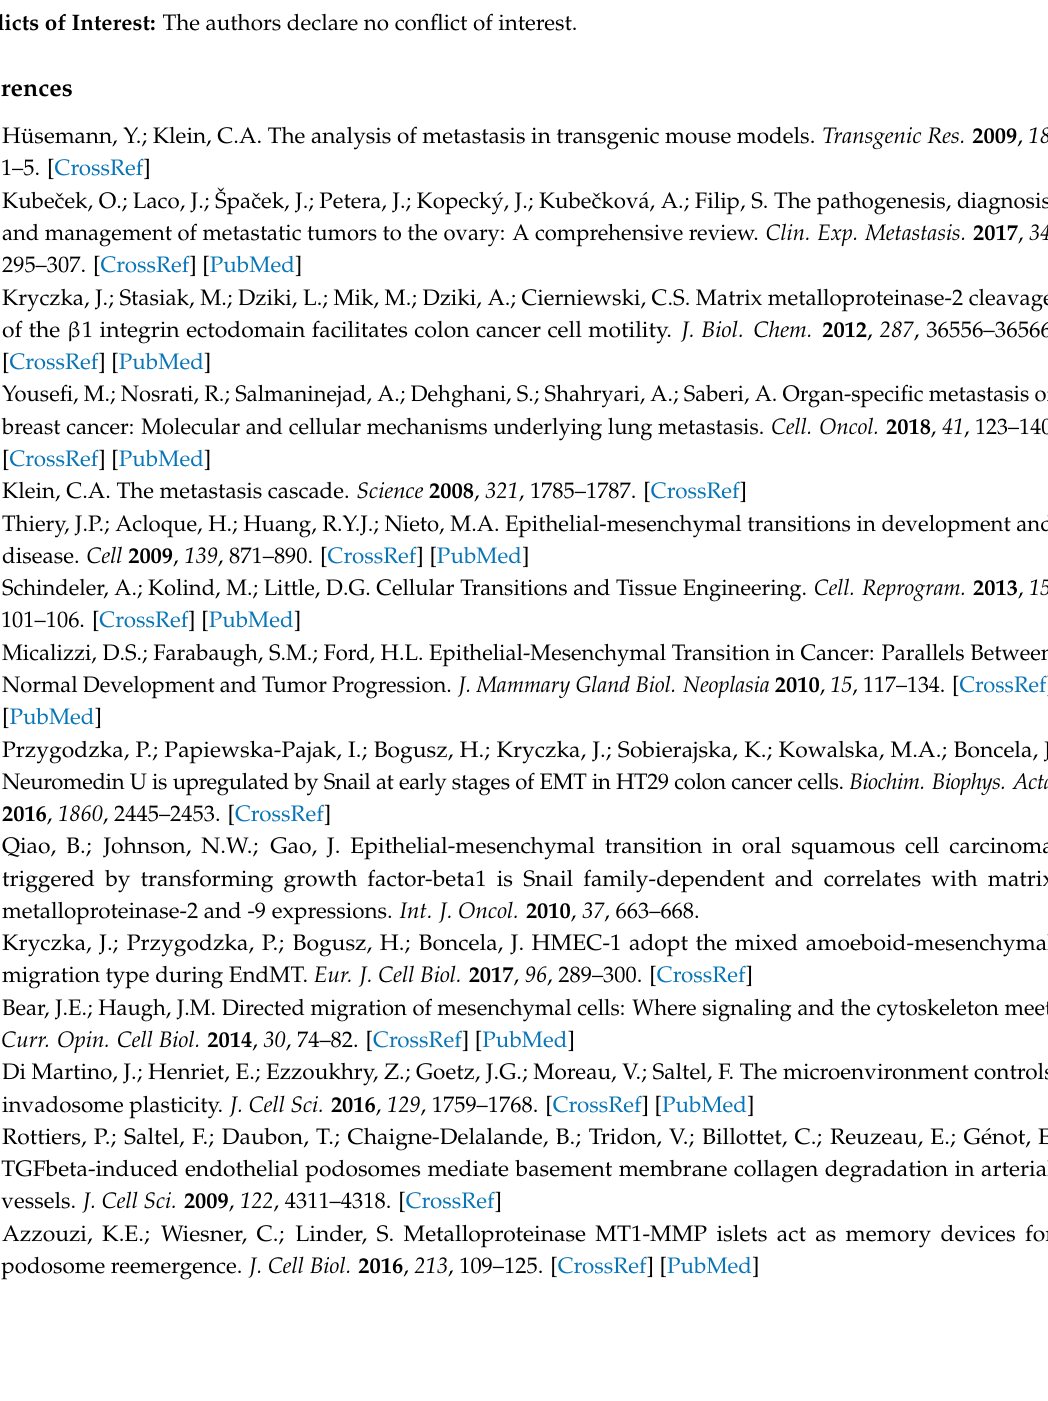
Figure S1: Invadosomes structures in HT-29 control cells, Figure S2: The representative image of Proteome Profiler Human Protease Array Kit (R & D System, ARY021) of medium or cell lysates from HT-29 control cells vrs.